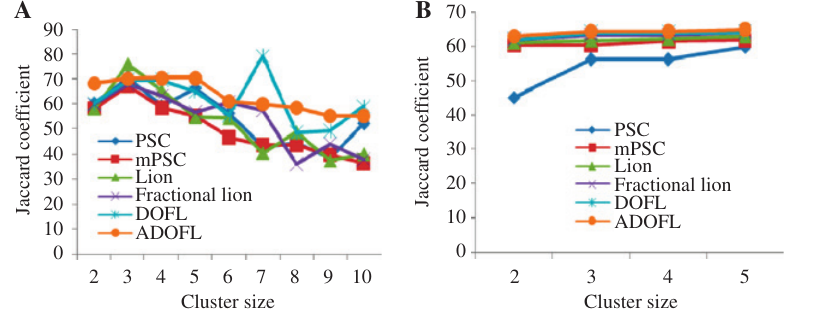
Figure 6: Jaccard Coefficient Analysis Curve. (A) Iris dataset. (B) Wine